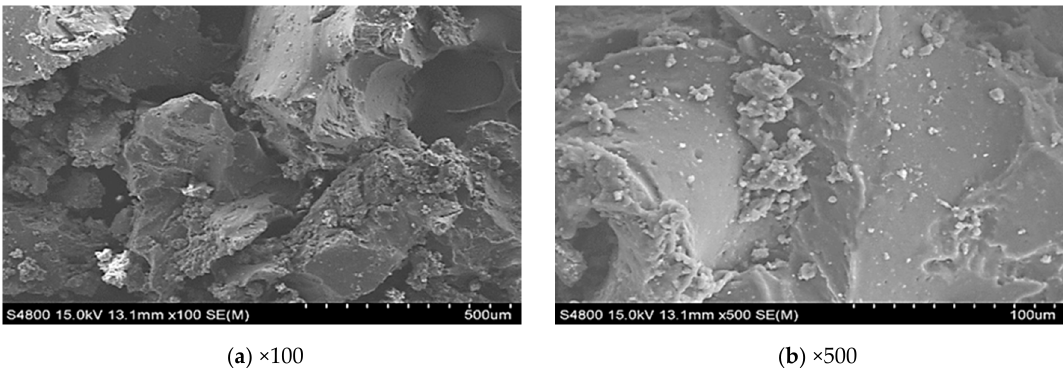
Figure 1. SEM image of the CR particles.